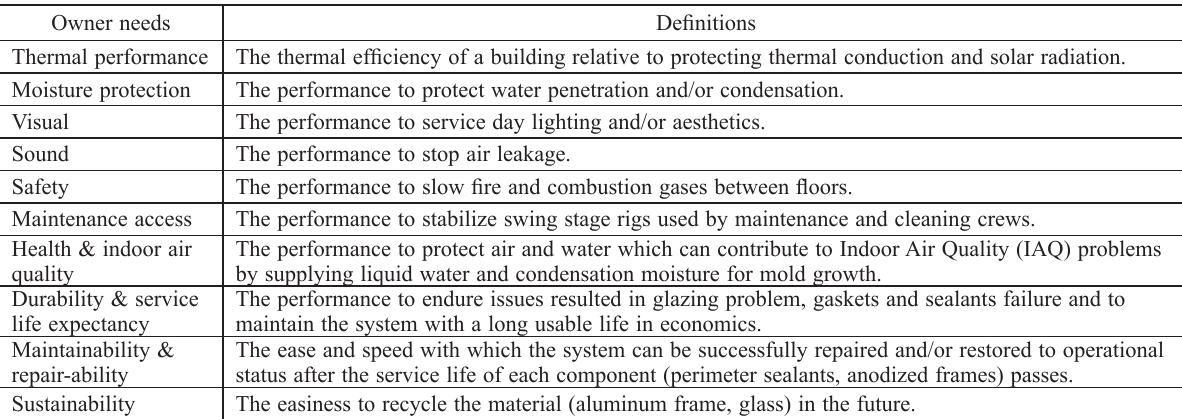
Table 1. Construction owner requirements for curtain-wall design (adapted from WBDG 1993) Owner